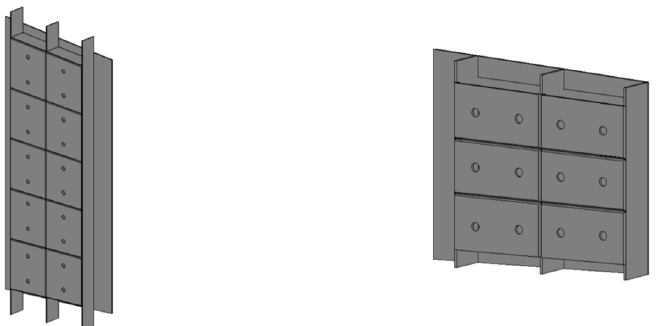
Figure 18. Holes on external panels with a diameter of 70 mm for inserting the liquid scintillator light detection devices.